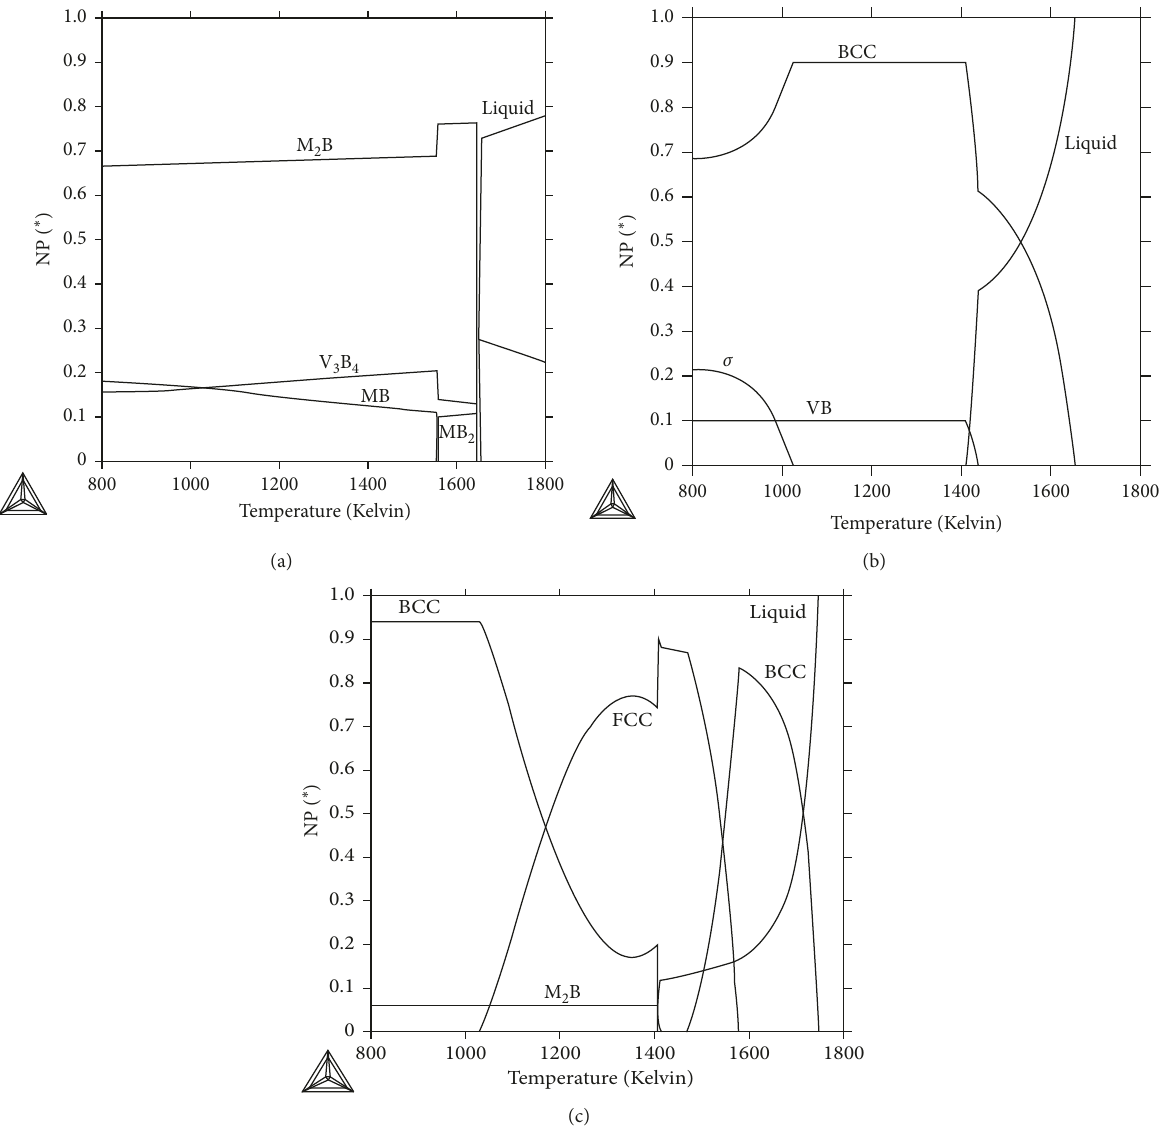
Figure 5: Calculated phase fractions in dependence on temperature for (a) alloy 1, (b) alloy 2, and (c) alloy